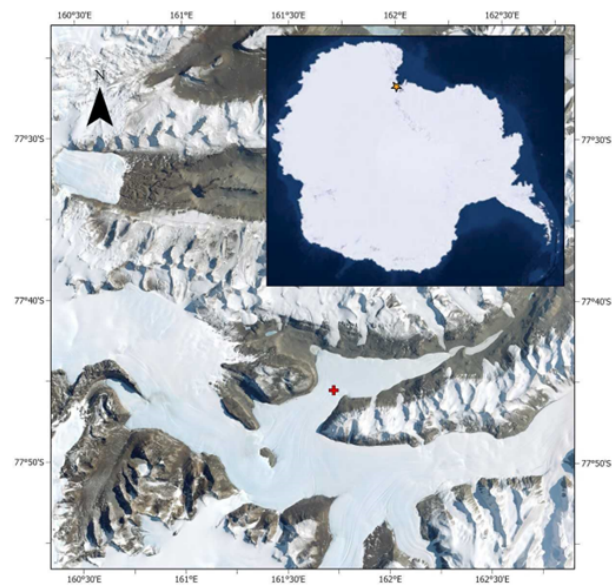
Figure 2. Map of the Taylor Glacier study site. The sampling loca- tion is marked by a red cross on the map. The orange star in the inset map shows the location of the Taylor Glacier relative to the Antarc- tic continent. The map was made using ArcGIS Pro, with imagery layers from Esri and Earthstar